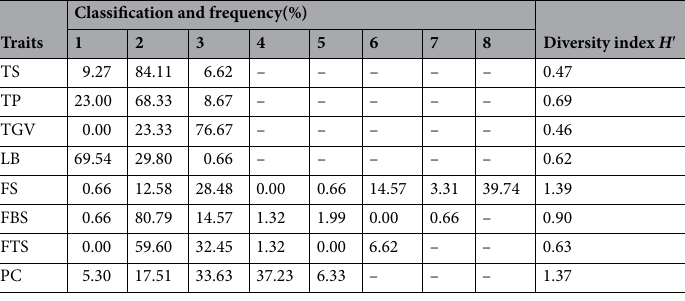
Table 2. Diversity analysis of qualitative traits. “–”: this item does not